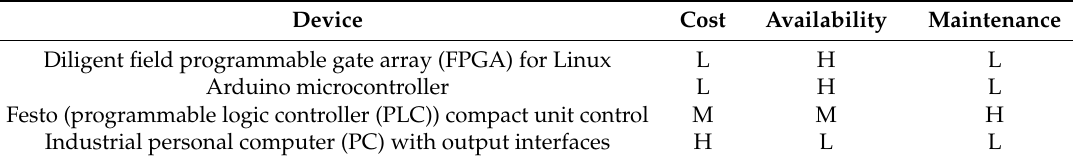
Table 4. Control device selection matrix.